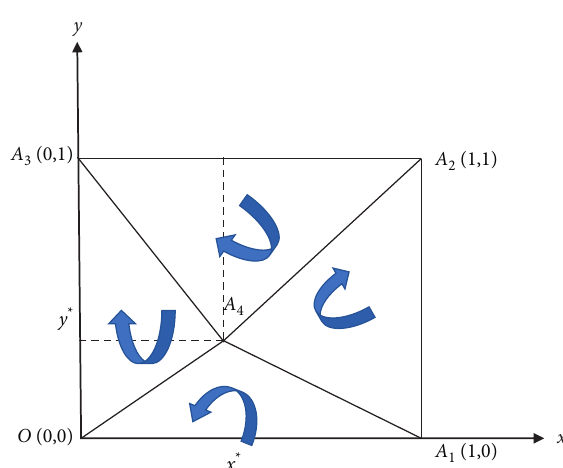
Figure 1: Manufacturers’ evolutionary stable strategy and sup- pliers’ evolutionary stable strategy evolve to (0,